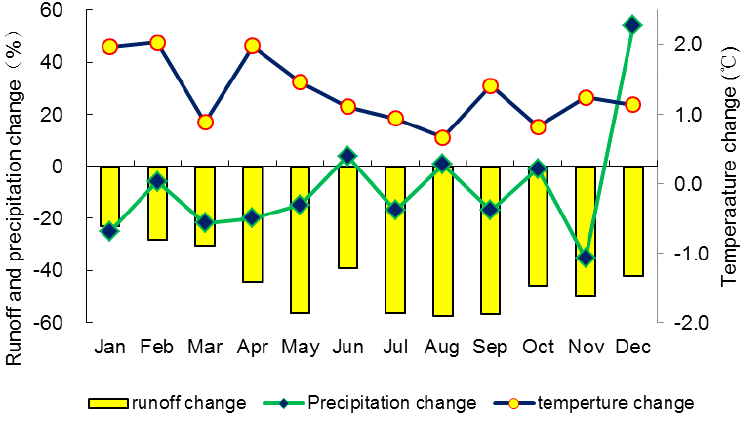
Figure 7. Seasonal changes in runoff (%), precipitation (%), and temperature (°C) for 1973–2008 relative to 1955–1972.